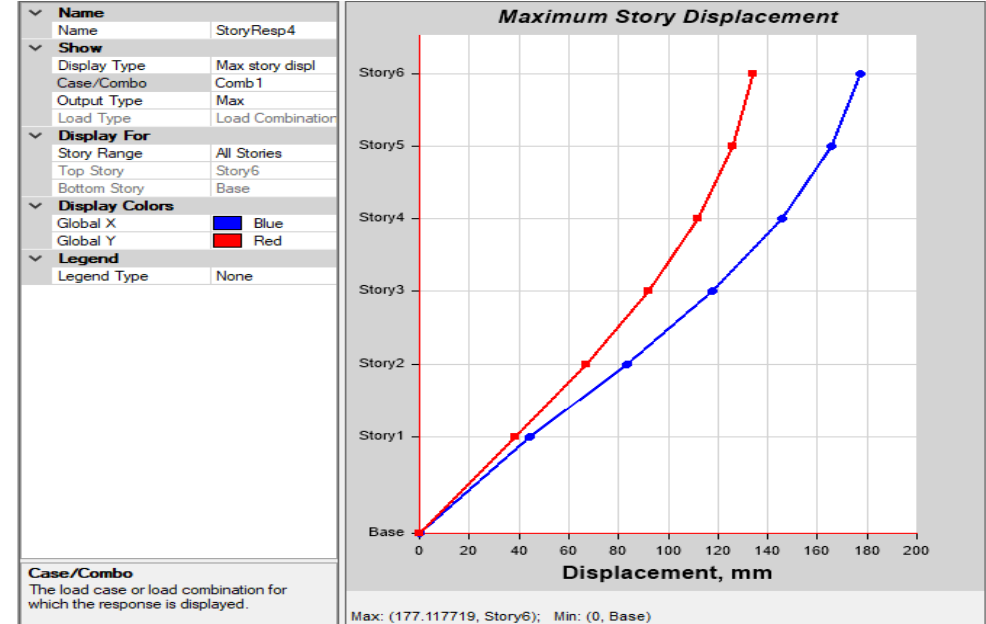
Figure 6. Maximum story displacement.